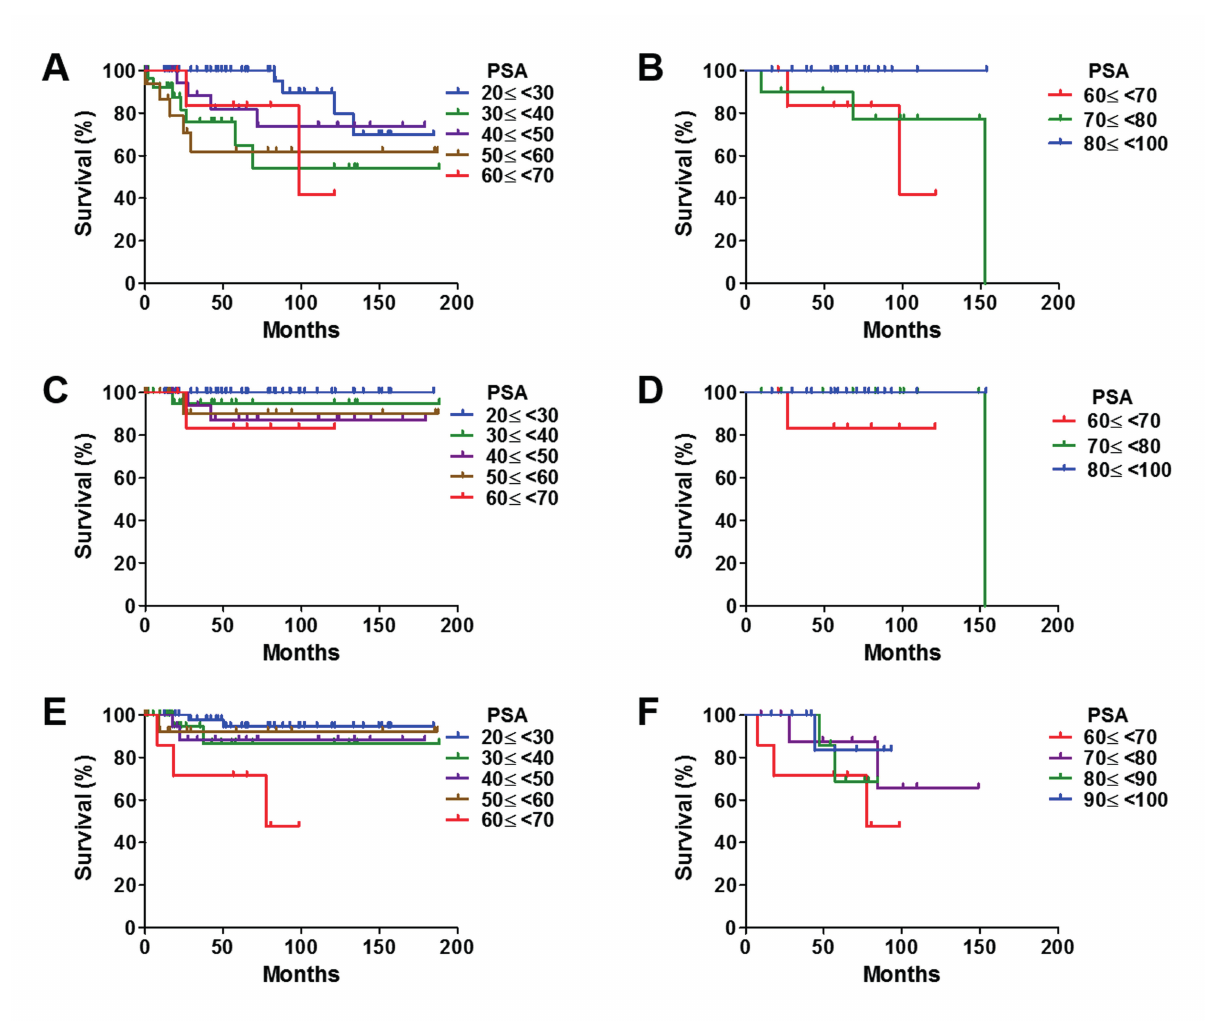
Figure 2 - Kaplan - Meier analyses of OS, PcaSS, and cFS in patients based on